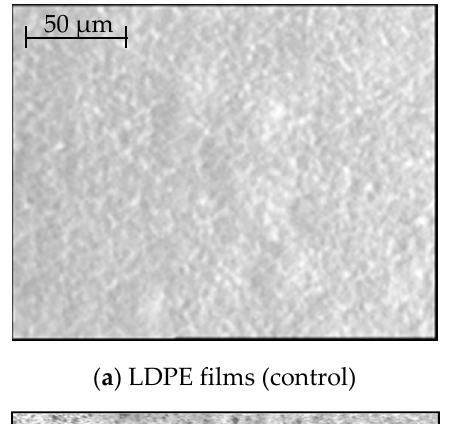
Figure 5. Photomicrographs of the surface of a betulin-modified LDPE film.